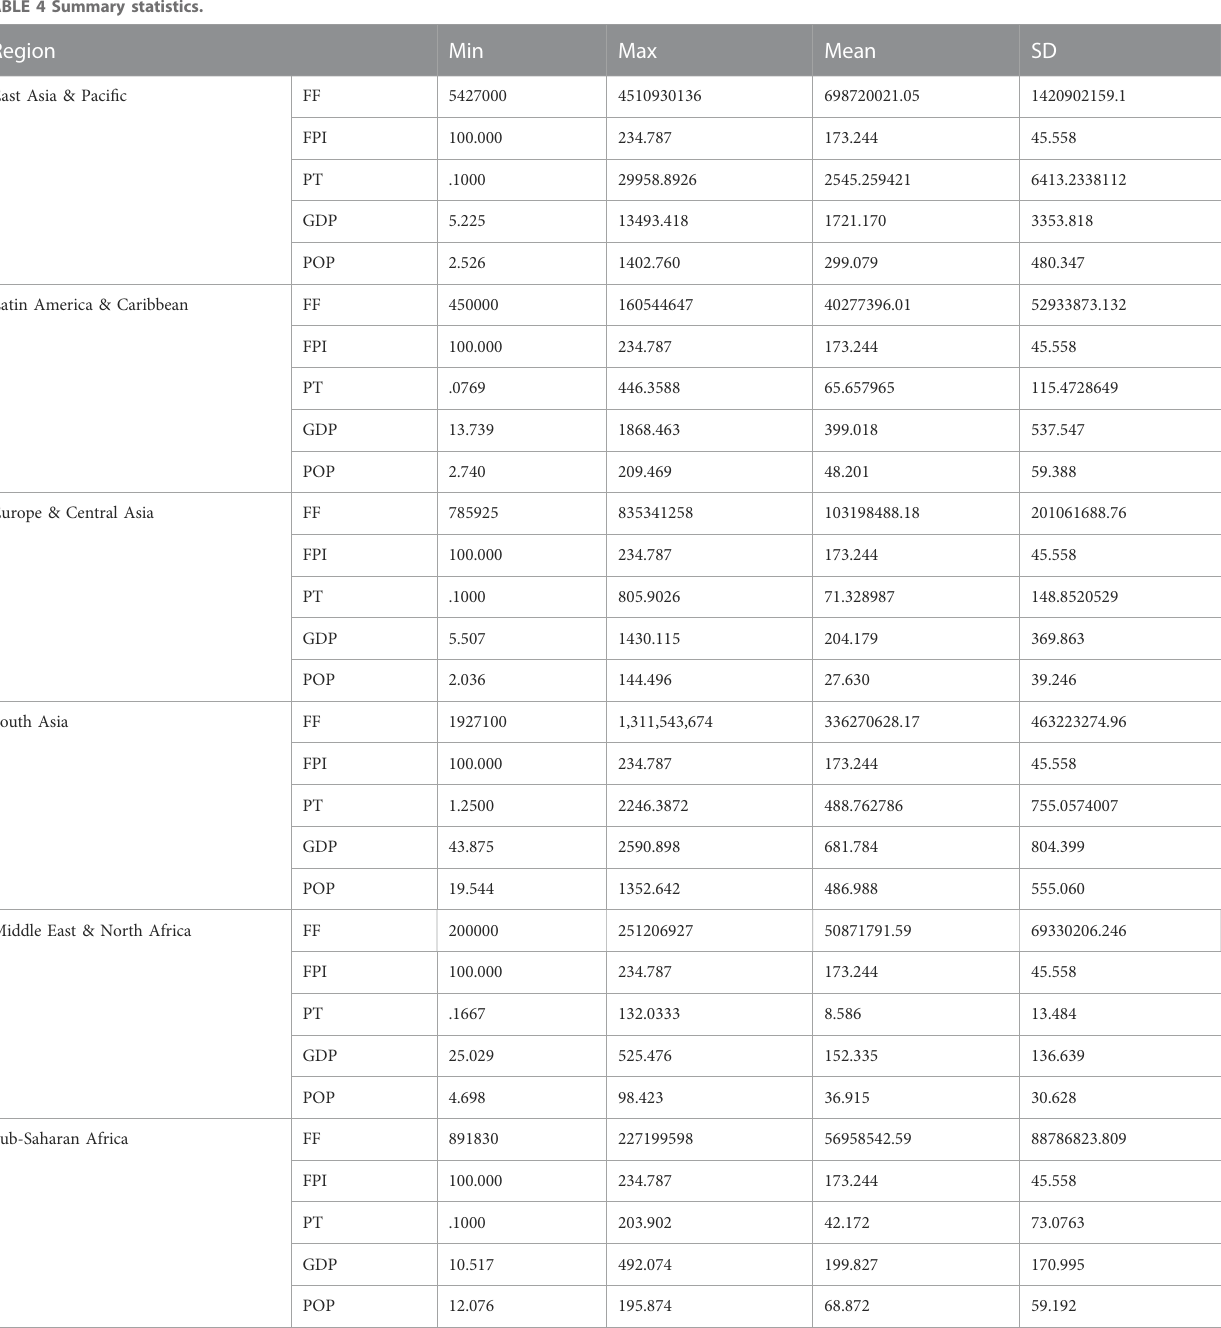
TABLE 4 Summary statistics.